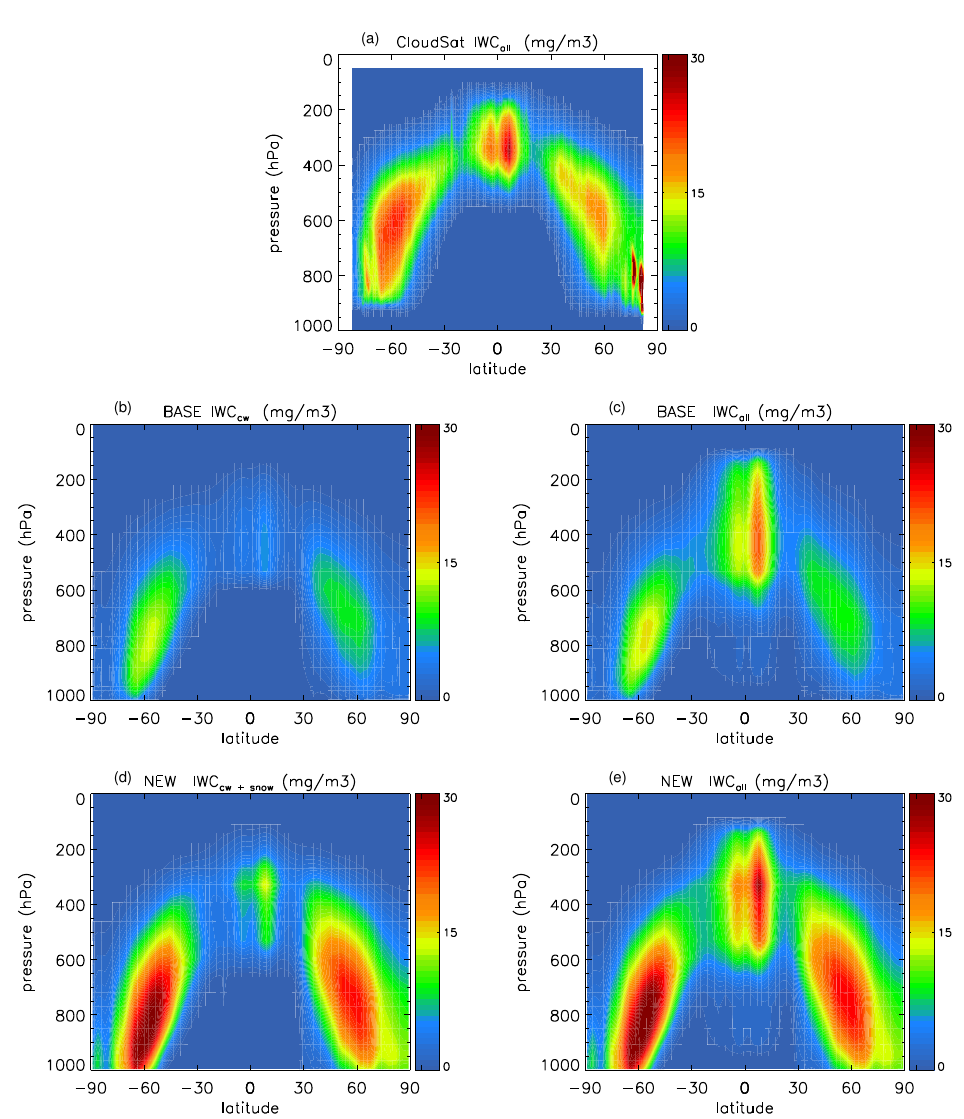
Fig. 8. Grid-box zonal mean ice water content (IWC) compared to “all sky” CloudSat retrievals (Waliser et al., 2009). Below ∼ 850hPa CloudSat (a) has sampling problems and hence there is no low-level IWC shown in (a). Stratiform IWC is shown in (b) for the BASE run and in (d) for the NEW run, for which the stratiform IWC includes diagnosed snow. The total IWC shown in (c) for the BASE run and in (e) for the NEW run also contains contributions from deep convective anvils and updrafts and from shallow convection. being investigated, the simulated PDF for T < 205 K is